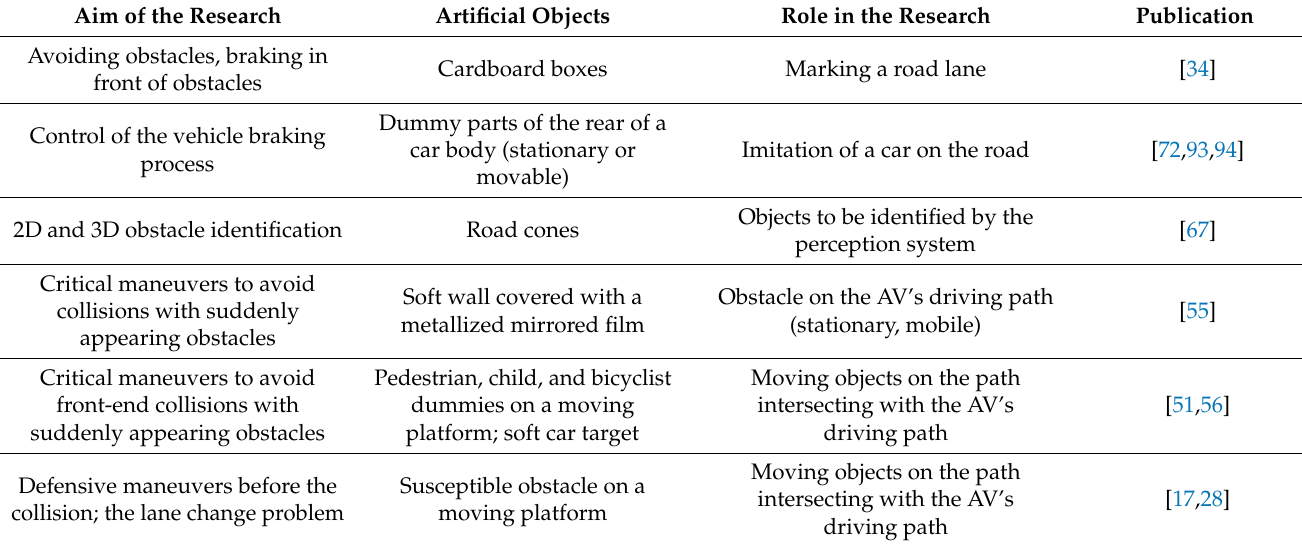
Table 5. Examples of artificial objects and their roles in the research scenario.